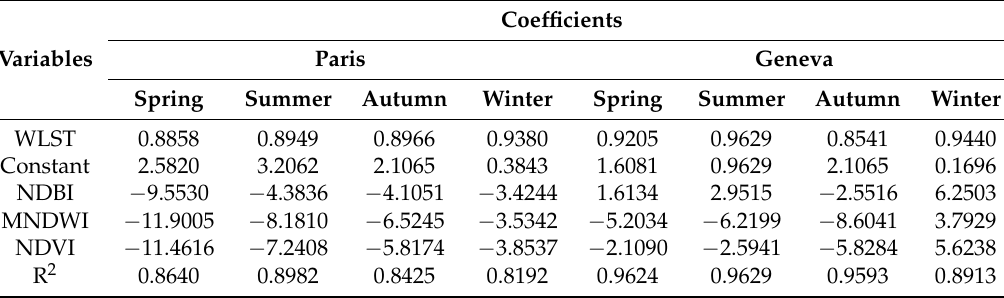
Table 3. Coefficients of indices with LST for